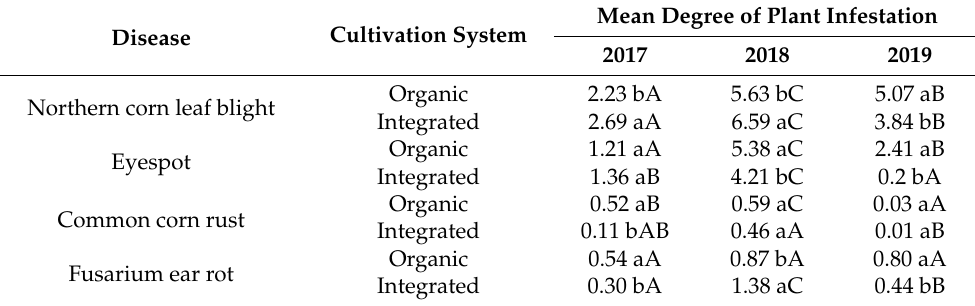
Table 4. Fungal disease occurrence in maize cultivated under organic and integrated systems of management in the years